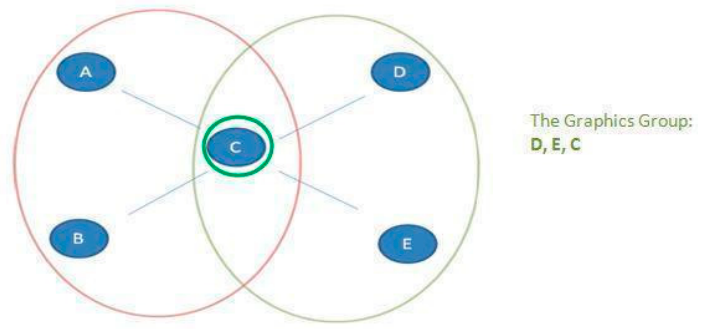
Figure 5. Study 4—Depiction of a centrality network.